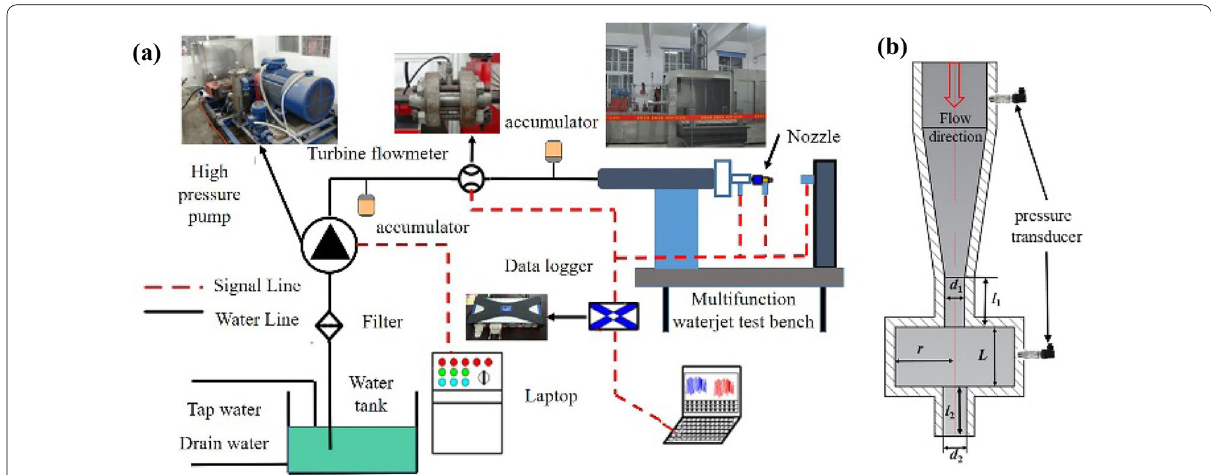
Figure 3 Schematic diagram of experimental setup: ( a ) experimental system, ( b ) tested section